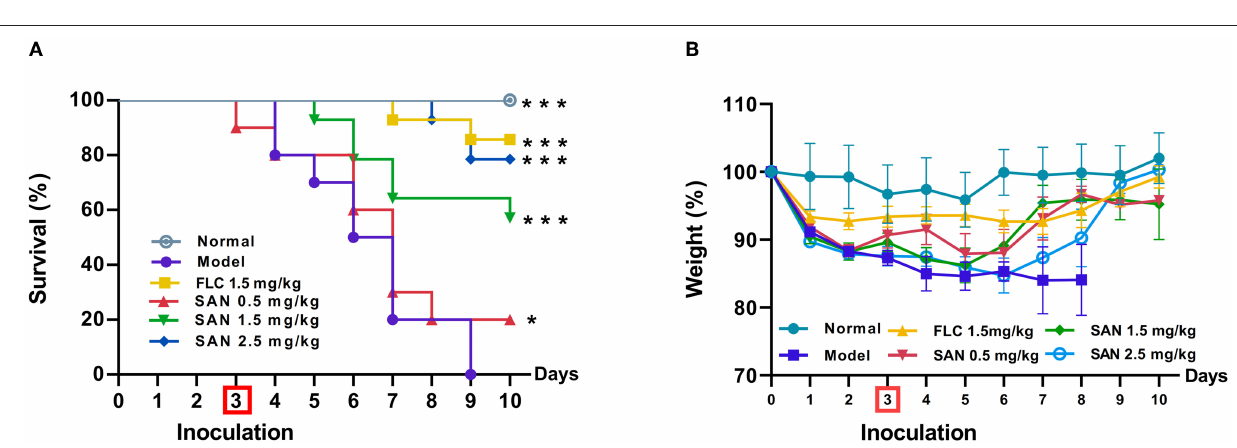
Frontiers in Microbiology |